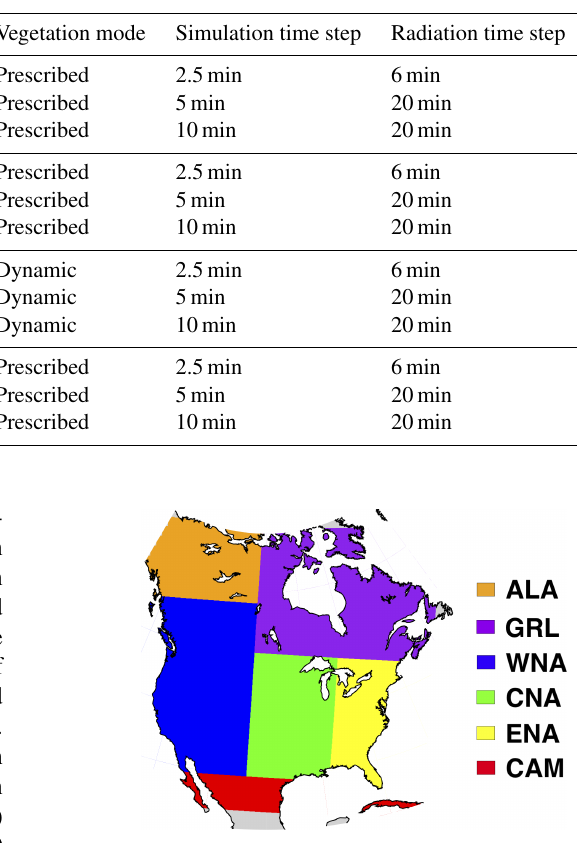
Figure 1. Subregions employed for the bias analysis, adapted from Giorgi and Francisco (2000): Central America, CAM; western North America, WNA; central North America, CNA; eastern North America, ENA; Alaska, ALA; and Greenland, GRL.